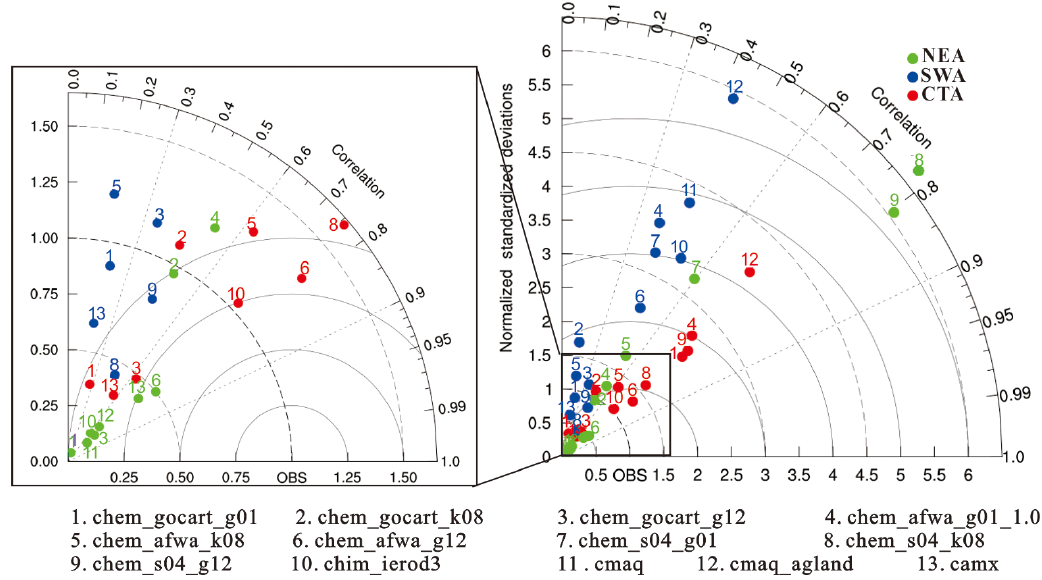
Figure 10. Taylor diagram comparing the hourly PM 10 concentrations of simulations with in situ measurements for three regions of NEC described in Fig. 2 (CTA, red circles; SWA, blue; NEA, green). The numbers correspond to individual simulations summarized in Table 3.